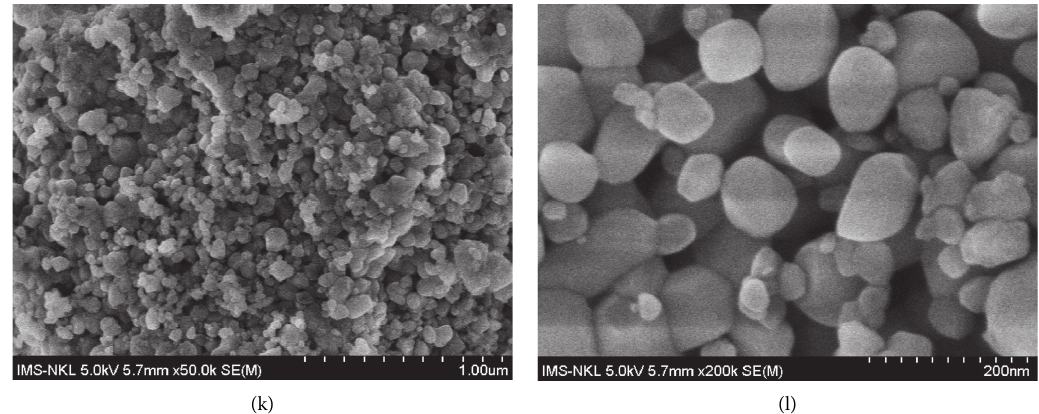
Figure 5: FESEM images of unmodified and modified ZrO 2 nanoparticles at magnification of 50,000 times and 200,000 times. u-ZrO 2 (a, b), m-ZrO 2 -3 (c, d), m-ZrO 2 -5 (e, f), m-ZrO 2 -7 (g, h), m-ZrO 2 -10 (i, j), and m-ZrO 2 -15 (k,